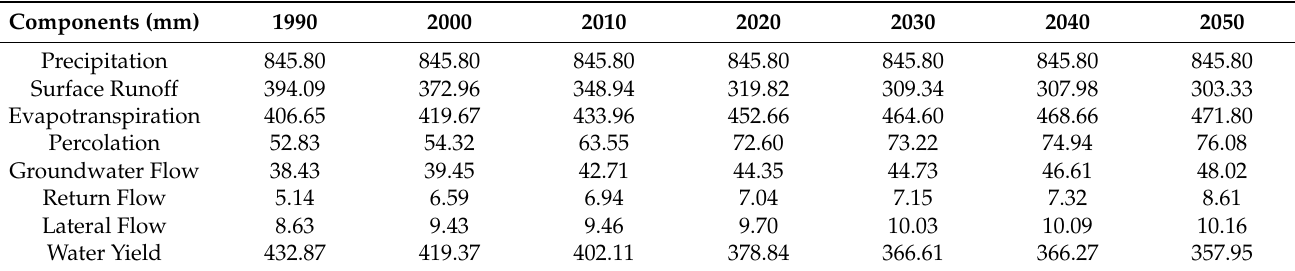
Table 6. Mean annual water balance components of the river basins.